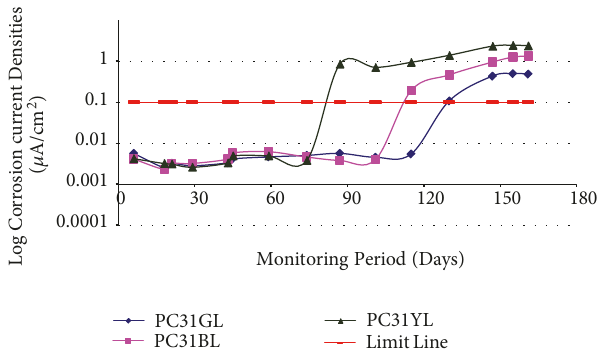
Figure 8: Log corrosion current densities versus time for OPC at w/c 0.80.